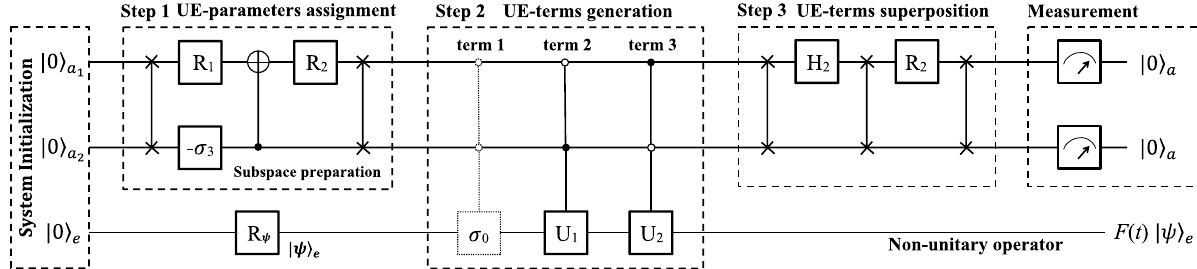
Figure 5. Quantum circuit for three qubits using a six-dimensional subspace. The three qubits is initialized to 00 0 ψ e . The six-dimensional subspace is prepared and the UE-parameters a e , and the qubit e is rotated to | � | � | � are assigned in the first step, taking a similar role as the U T 1 in Fig. 4. Then the three UE-terms are generated by three controlled-controlled operators in the second step, where the first dashed one is unnecessary in practice. In the third step, a series of operations is applied to the ancillary qubits to superpose the three UE-terms as the effect of U T 2 in Fig. 4. Finally, measurements are performed on the ancillary qudits to simulate F ( t ) in a probabilistic